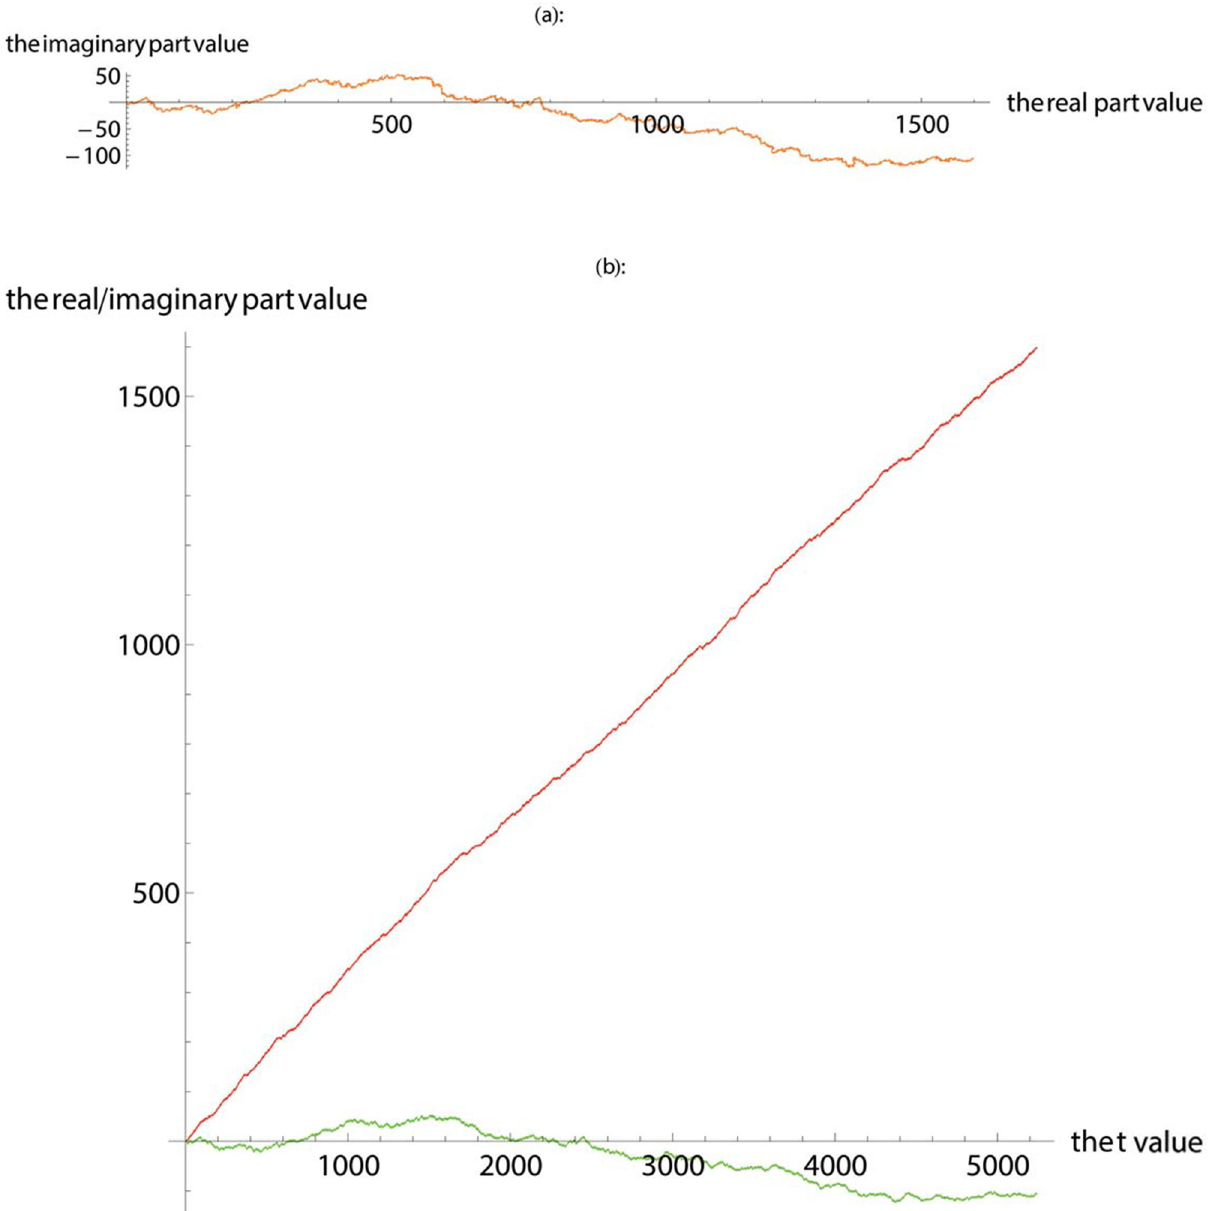
Fig 1. The TP walk of the coding region downloaded from the UniProt database. ( a ) Plot the walk trace in the complex plane. ( b ) Plot the real part (red) and imaginary part (green).